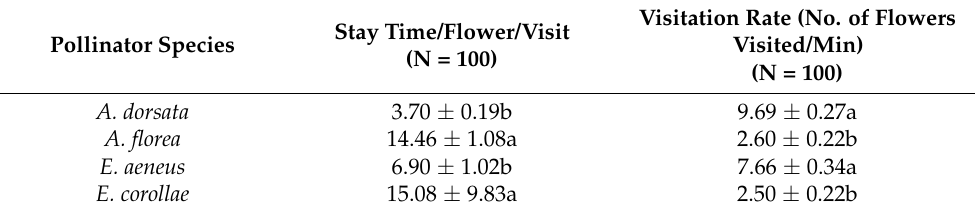
Table 2. Foraging behavior of two honey bee and two syrphid fly species in terms of stay time and visitation rate in a strawberry field in Multan, Pakistan.